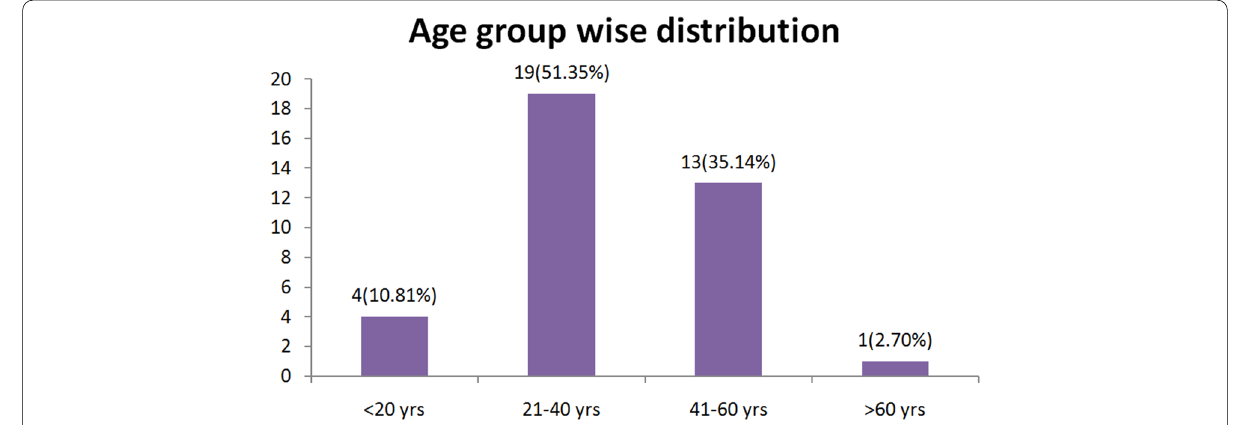
Fig. 1 Distribution of cases according to age group (number,